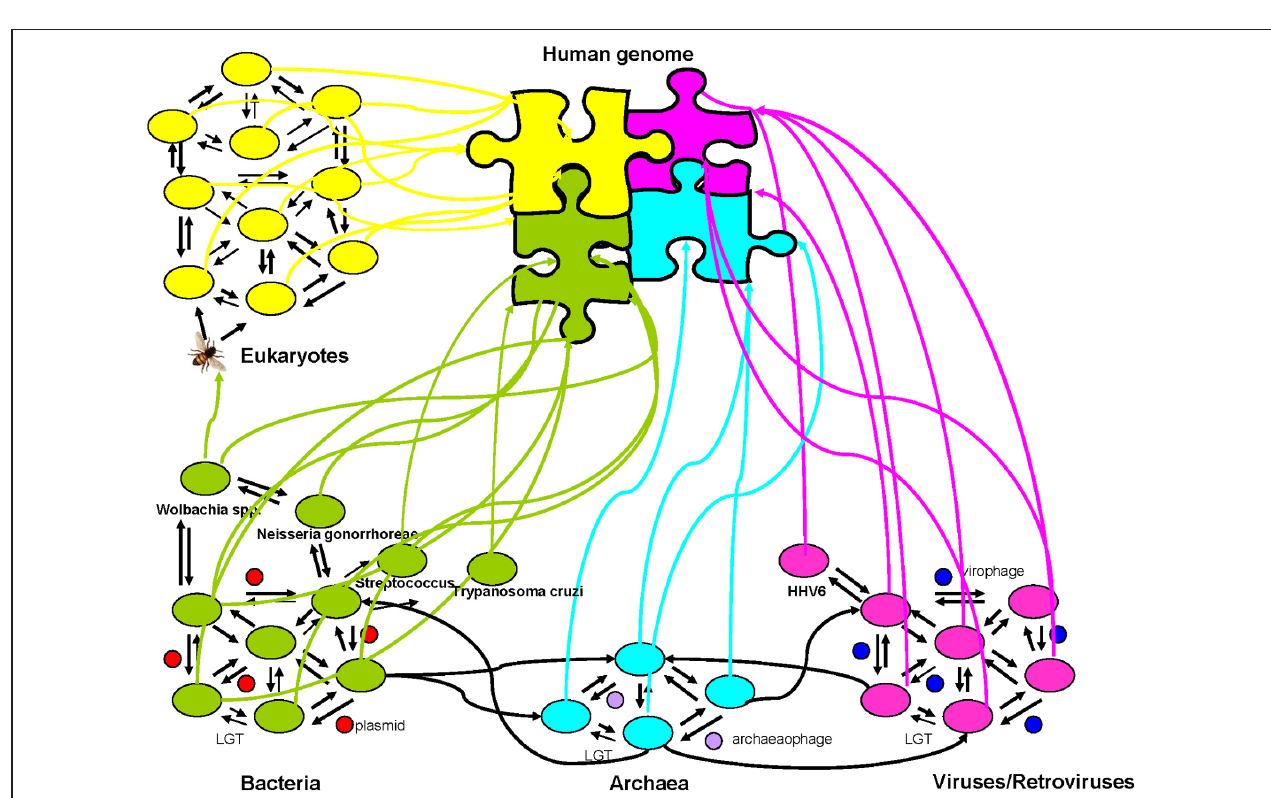
inherited elements from ancestors and from laterally inherited elements from other eukaryotes, bacteria, and viruses. The arrows identify the lateral sequence transfers, and the colorful arrows indicate the transfer events toward